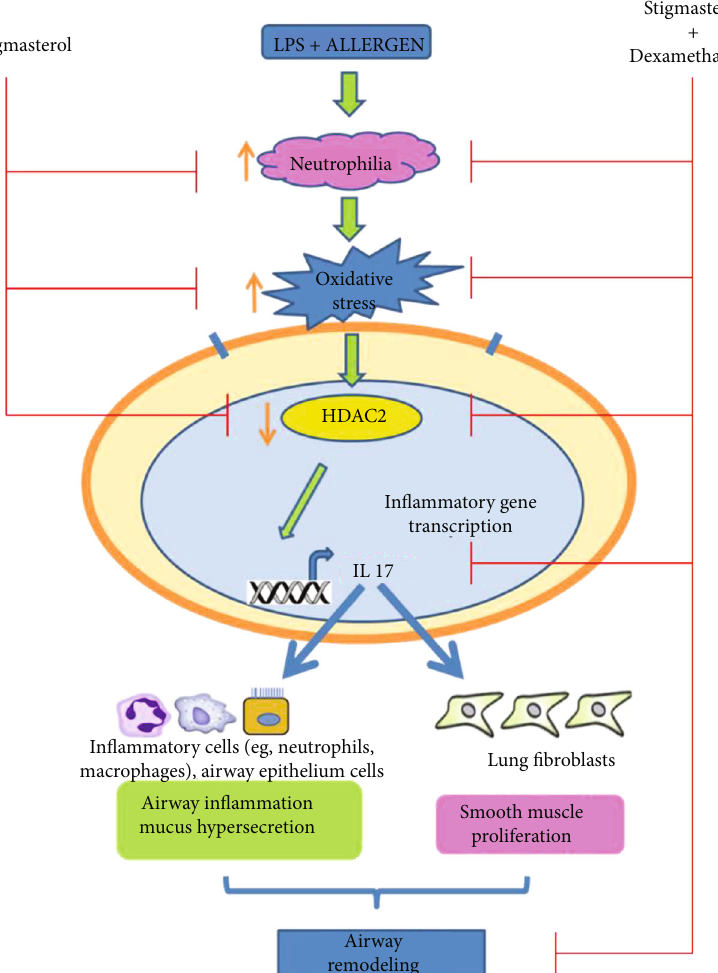
Figure 8: Graphical abstract. Stigmasterol-dexamethasone (STIG+DEX) coadministration is more e ff ective in inhibiting steroid-resistant asthma compared to stigmasterol